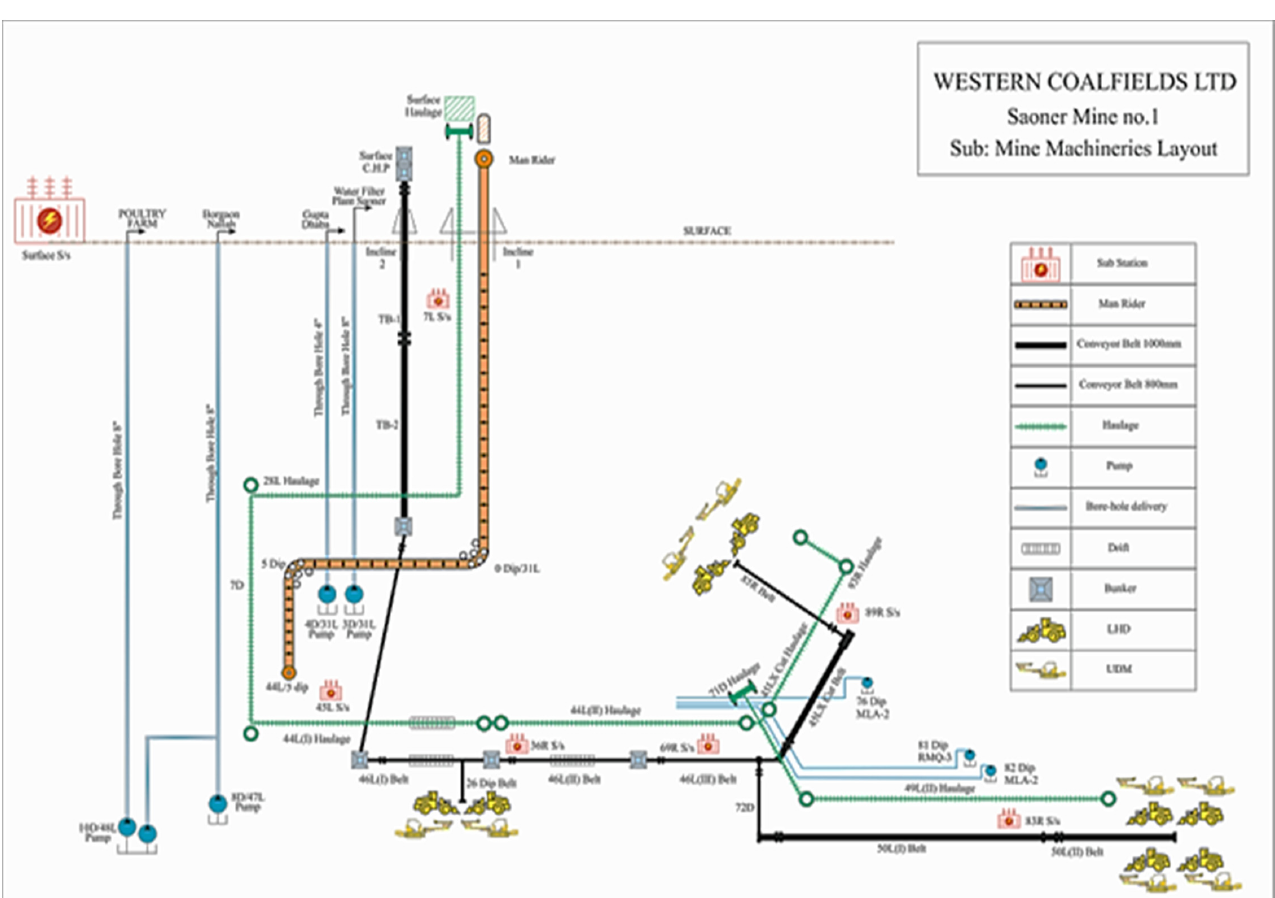
Figure 1. Detailed layout of underground coal mine of Saoner Mine No.1, Nagpur Area, Western Coal Fields Limited, Coal India Limited, India.